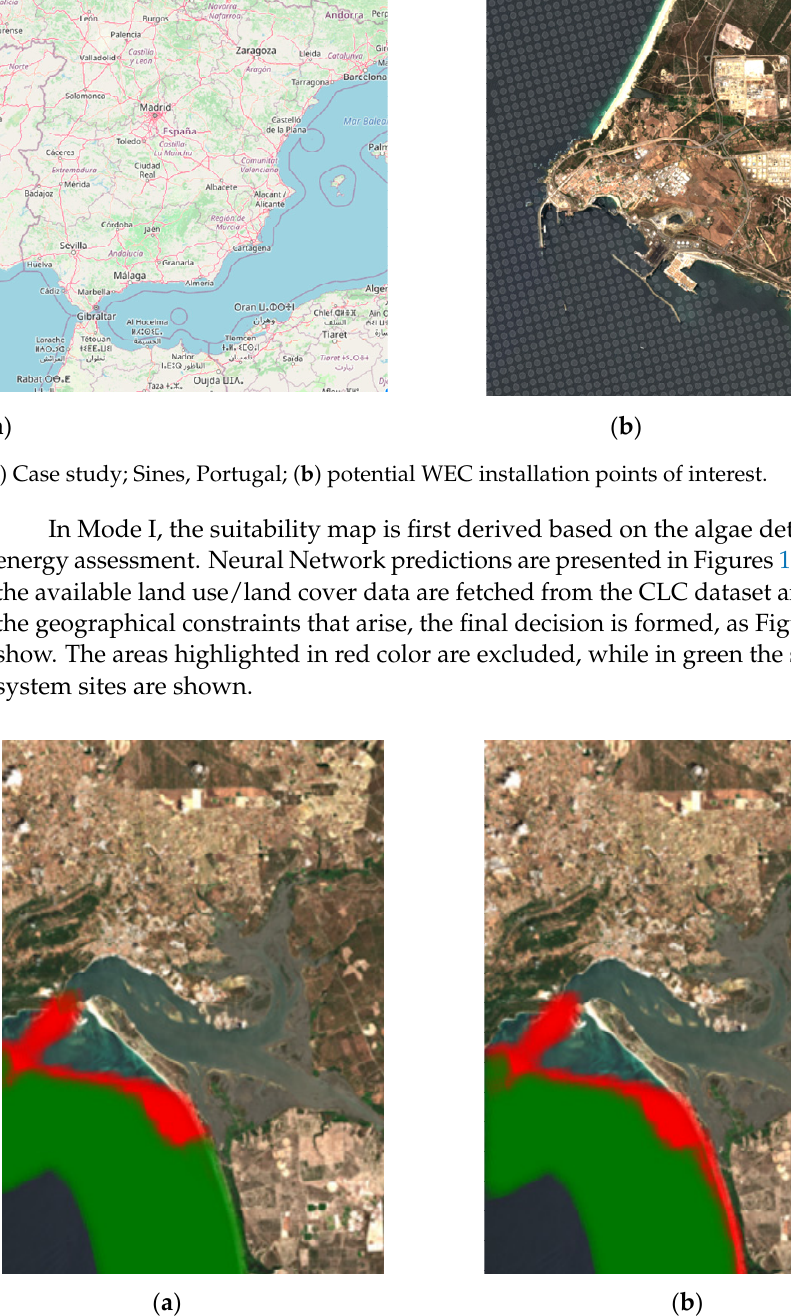
Figure 13. ( a ) Neural Network Prediction; ( b ) final decision considering land use data.